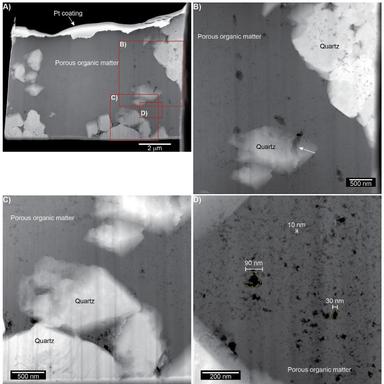
A) Overview of the TEM foil used to study the porosity associated with organic matter in the Marcellus Shale. Image acquired in HAADF mode. Black = background; white = platinum strip; dark grey = organic carbon; light grey = quartz. B) Detail of pores within the organic matter and at the interface between quartz crystals and the surrounding organic material (white arrow). C) Interstitial porous organic material between micron-sized quartz grains. D) Range of pore sizes within the organic material typically